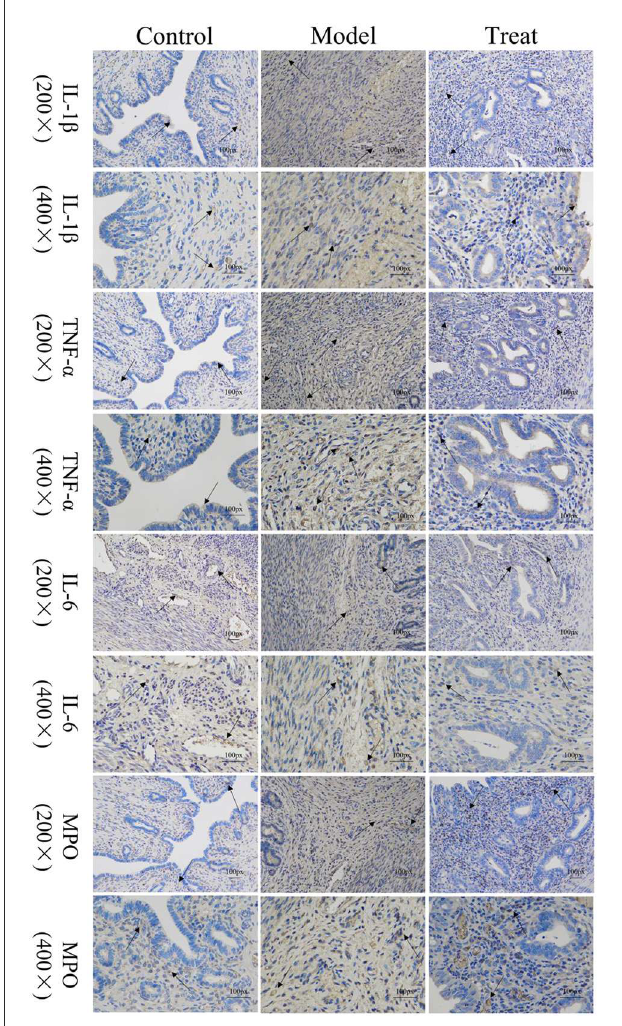
FIGURE6 Localized expression of various inflammatory factors and MPO in uterine tissues. Arrows point to: positive staining area.